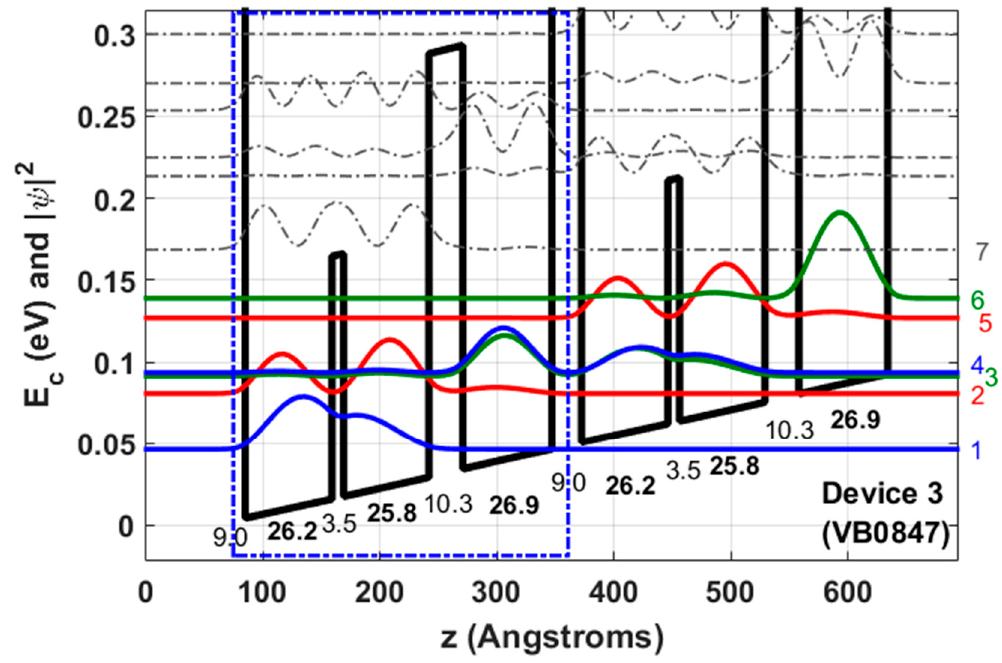
Figure 5. Band diagram of two sequential periods labeled module i (left, the dashed-dotted box) and module i + 1 (right) of Device 3 (wafer VB0847) with mixed barriers: the Al 0.55 Ga 0.45 As injection barrier, the Al 0.30 Ga 0.70 As radiative barrier and the Al 0.15 Ga 0.85 As intra-well